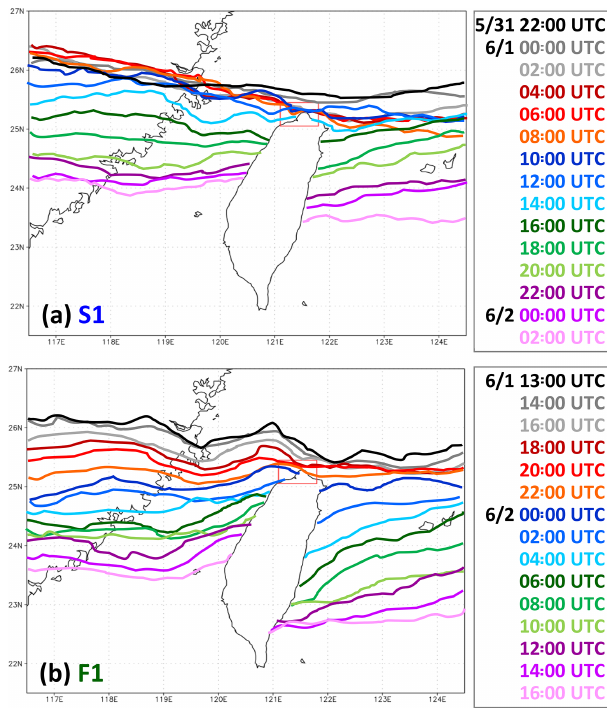
Figure 8. Model-simulated surface frontal positions every 2h (a) from 22:00UTC on 31 May to 02:00UTC on 2 June in ex- periment S1 and (b) from 13:00UTC on 1 June to 16:00UTC on 2 June 2017 in experiment F1 (additional position at 13:00UTC on 1 June),